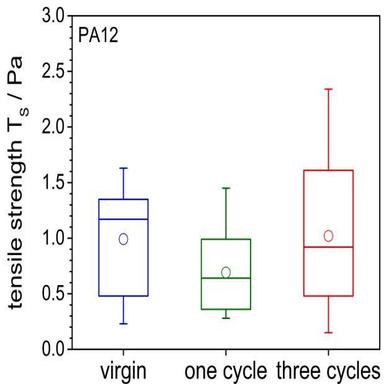
Tensile strength of PA12 powder for different states of aging. Measurements for each powder have been performed at least 15 times. The boxes in the boxplot describe the upper and lower quartile, all remaining measurement values are within the upper and lower whiskers. The circles denote the arithmetic mean.